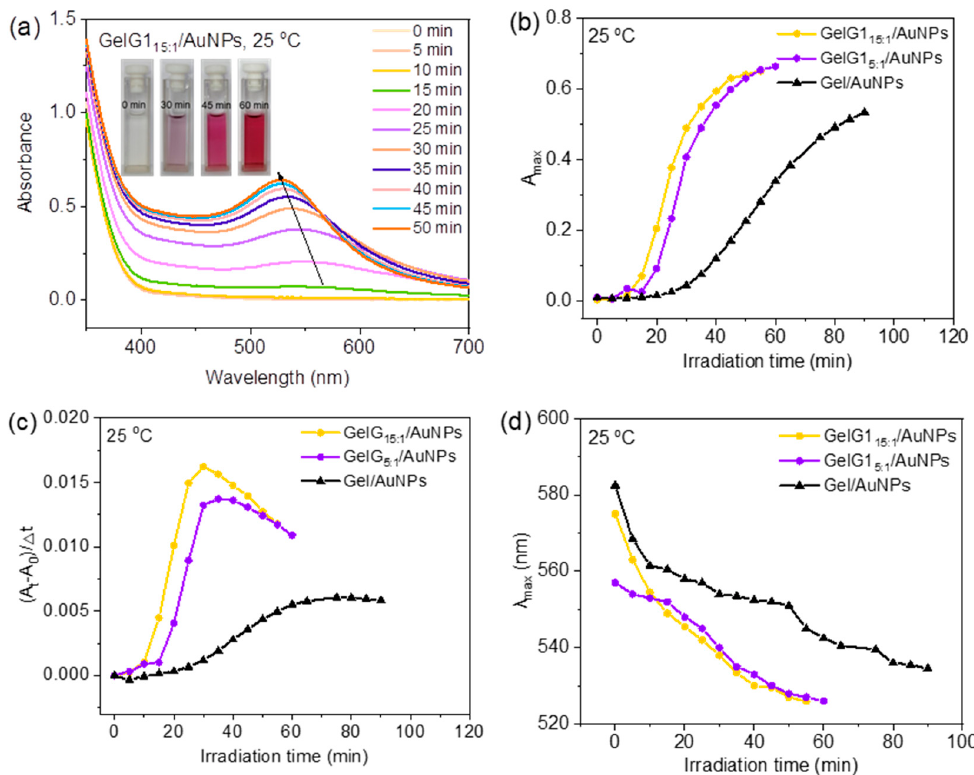
Figure 3 . ( a ) UV/vis absorption spectra of AuNPs obtained by in situ reduction of HAuCl 4 (0.1 mg/mL) with GelG1 15:1 (2 mg/mL) through irradiation with UV light (365 nm, 30 W) at 25 °C. Inserts are photographs of aqueous solutions of GelG1 15:1 and HAuCl 4 after UV irradiation for different time. Plots of A max ( b ), reduction rate ( c ) and λ max ( d ) with irradiation time for in situ reduction of HAuCl 4 (0.1 mg/mL) with GelG1 15:1 , GelG1 5:1 and gelatin (2 mg/mL) at 25 °C.